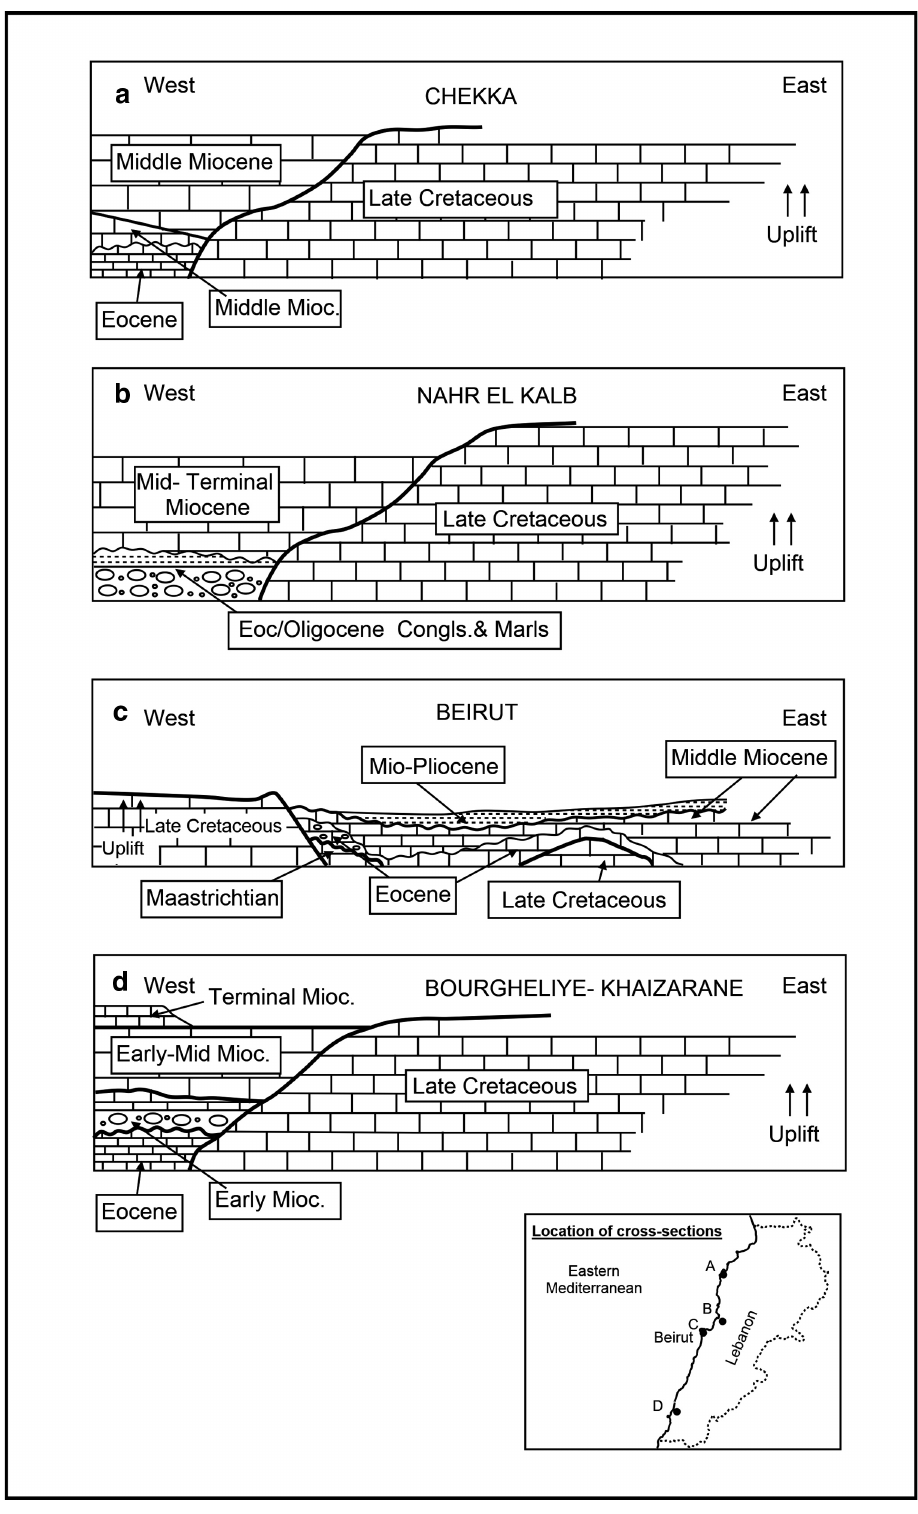
summary of the preserved Cenozoic marine sections of the Lebanon coastline during the Middle to Late Miocene. Note the exceptional Beirut profile where there was a pre-existing relief in the west controlling the platform from the NE and